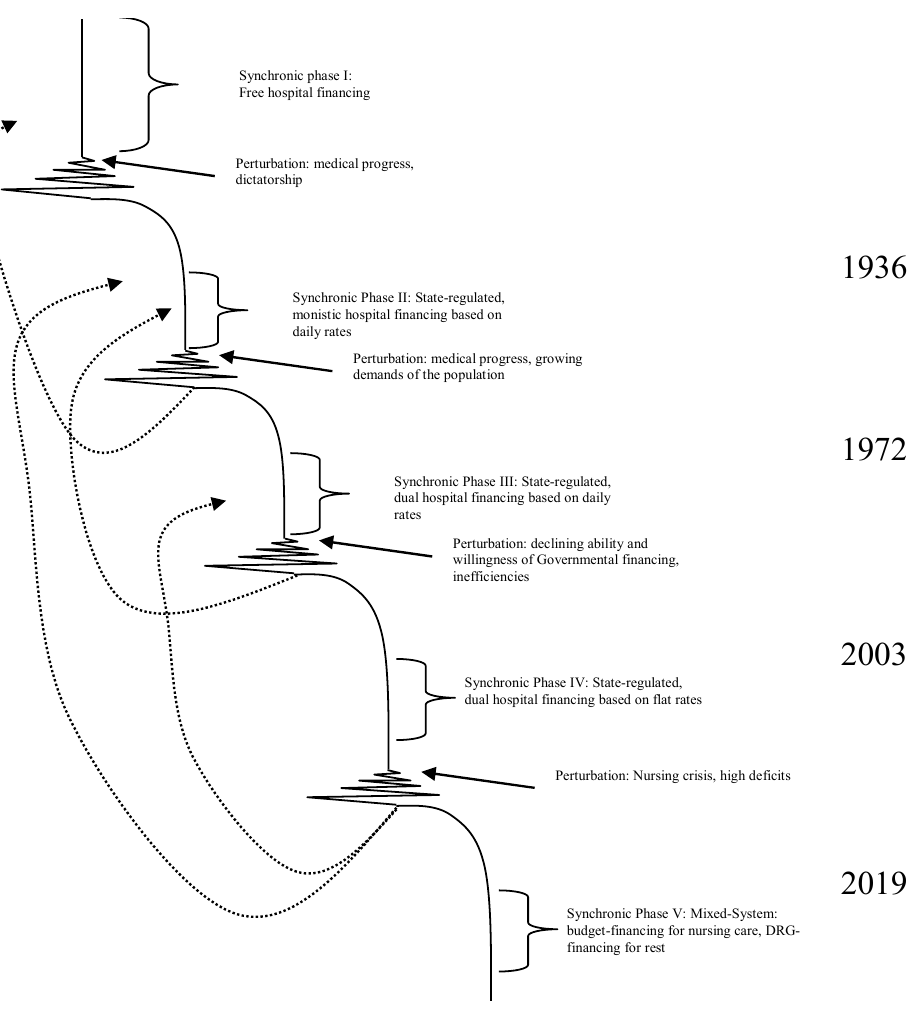
Figure 8 . Phases of German hospital financing. Source own, based on [9]. Figure 8. Phases of German hospital financing. Source own, based on